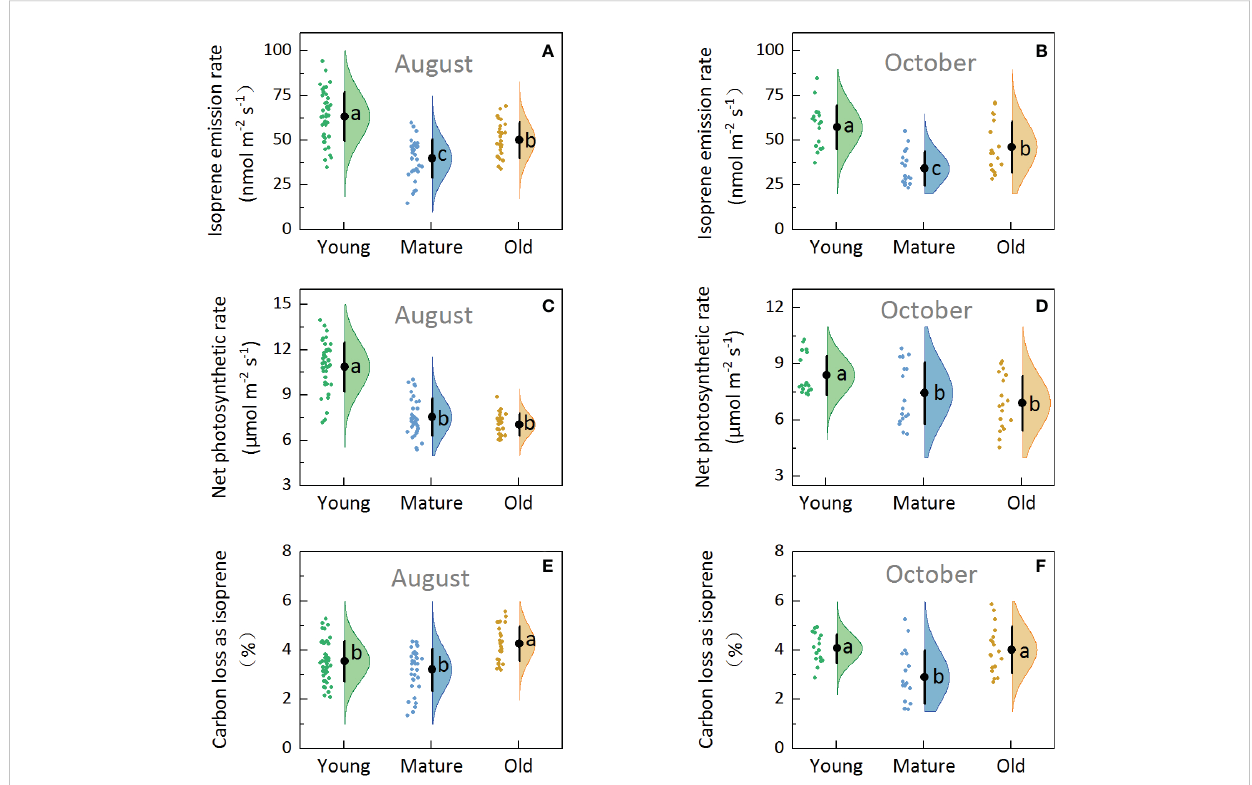
FIGURE 2 Rain cloud plot of isoprene emission and photosynthetic parameters with isoprene emission rate (A, B) , net photosynthetic rate (C, D) , percentage of carbon loss as isoprene (E, F) of Moso bamboo in August and October. The “ cloud ” represents the data distribution, and the “ rain ” represents the jittered raw data. The black point represents the mean distribution values, and the black line represents the standard deviations of the distributions. Lowercase letters indicate signi fi cant differences among young, mature, and old culms (P<